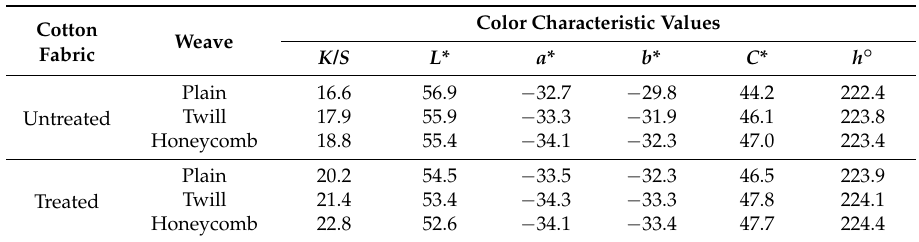
Table 2. The color strength and colorimetric parameters of ink-jet printed cotton fabrics with different structures a .